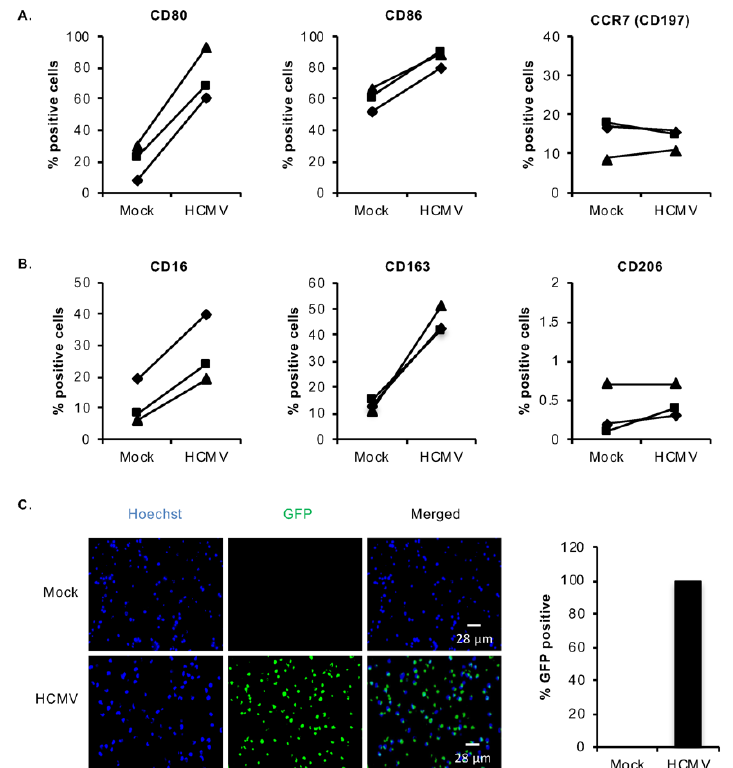
Figure 1. Human cytomegalovirus (HCMV) infection in monocytes induces select M1 / M2 macrophage di ff erentiation markers. Human peripheral blood monocytes were mock- or HCMV-infected with TB40E and the percent of cells positive for ( A ) M1 pro-inflammatory macrophage markers or ( B ) M2 anti-inflammatory macrophage markers were measured by flow cytometry at 48 hpi (CD80, CD86, CD16, CD163, and CD206) or 72 hpi (CCR7). ( A , B ) Results are representative of 3 independent experiments using monocytes from di ff erent donors, with each line representing matched data points from a single donor. ( C ) Monocytes were mock- or HCMV-infected with TB40E-GFP for 72 h. Cells were stained with Hoechst dye and visualized on a ZOE fluorescent cell imager. GFP-positive cells were counted as a percentage of the total number of Hoechst-positive cells. The bar graph represents the mean from 2 independent experiments using monocytes from one donor. Error bars represent the standard deviation.